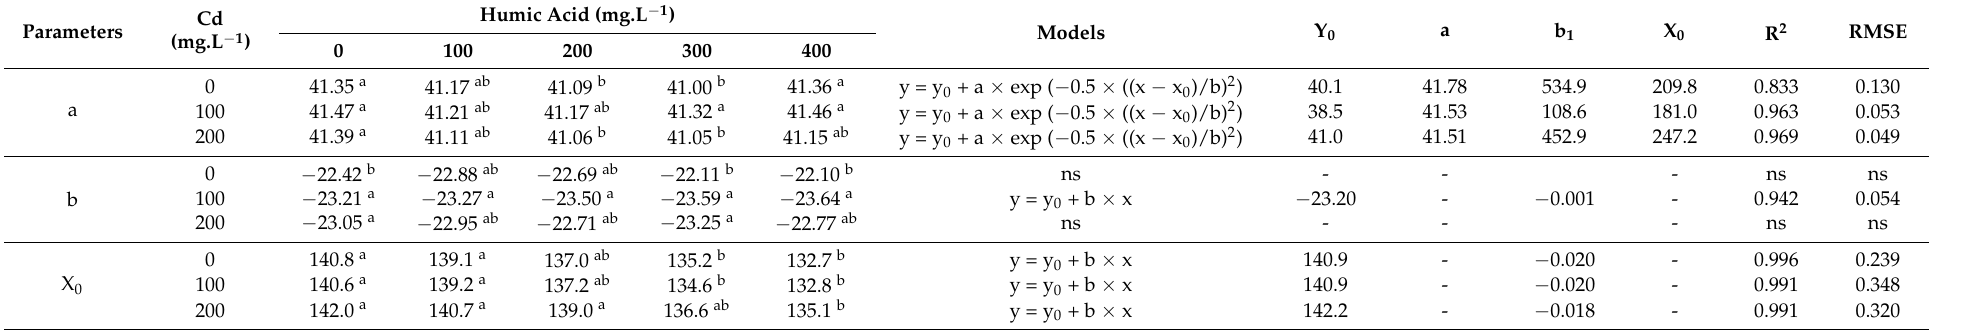
Table 3. Estimated parameters of lipid stimulation in pumpkin seeds ( Cucurbita pepo L.) influenced by humic acid under Cd